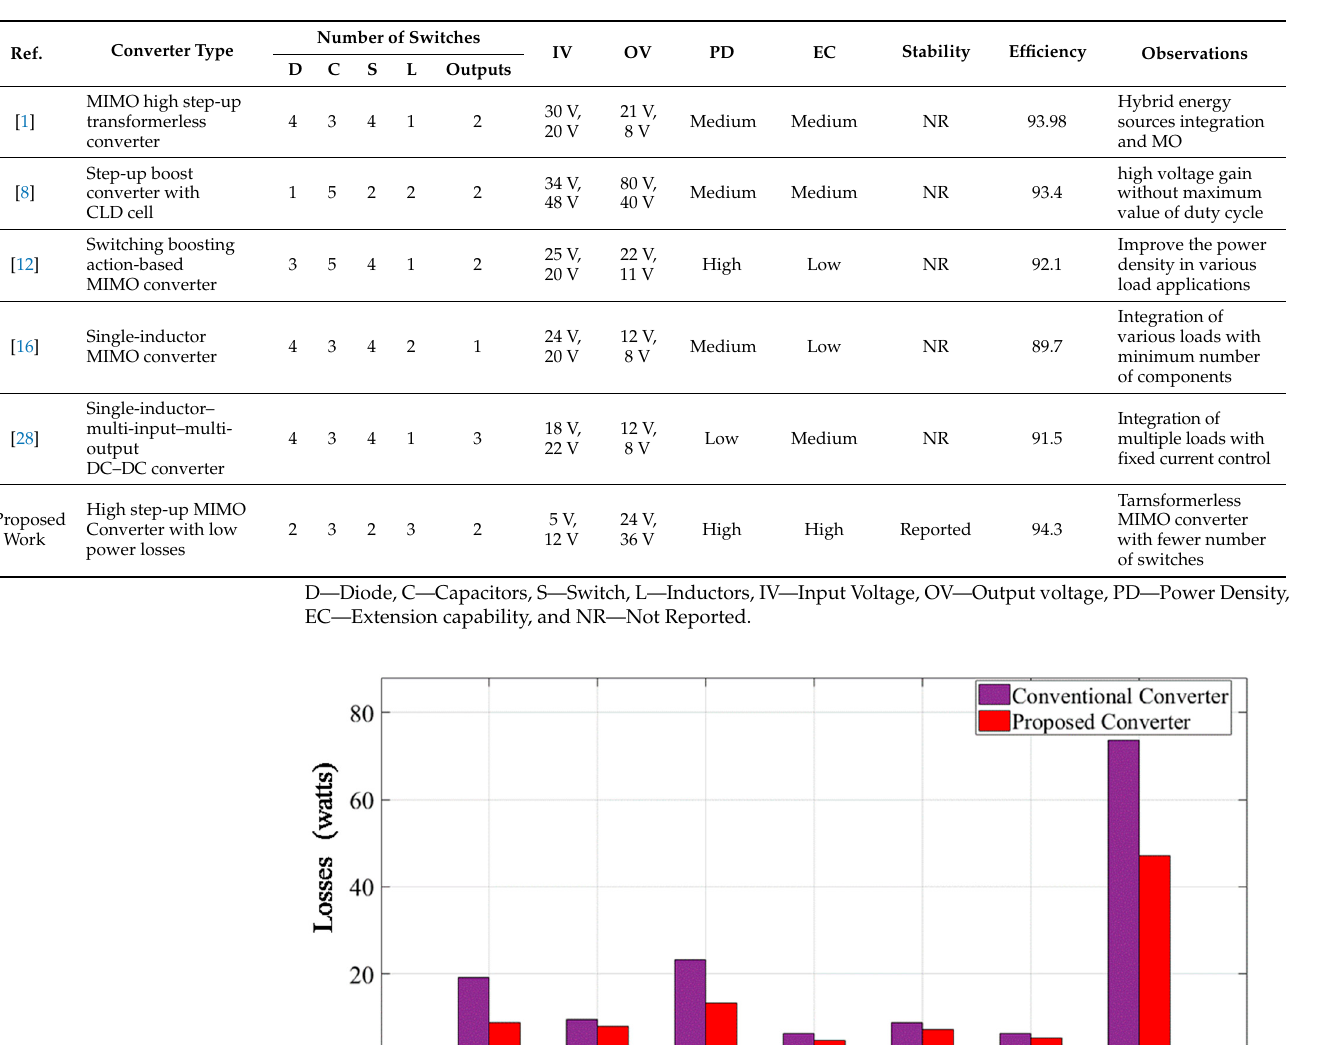
Table 2. Comparison with existing works.